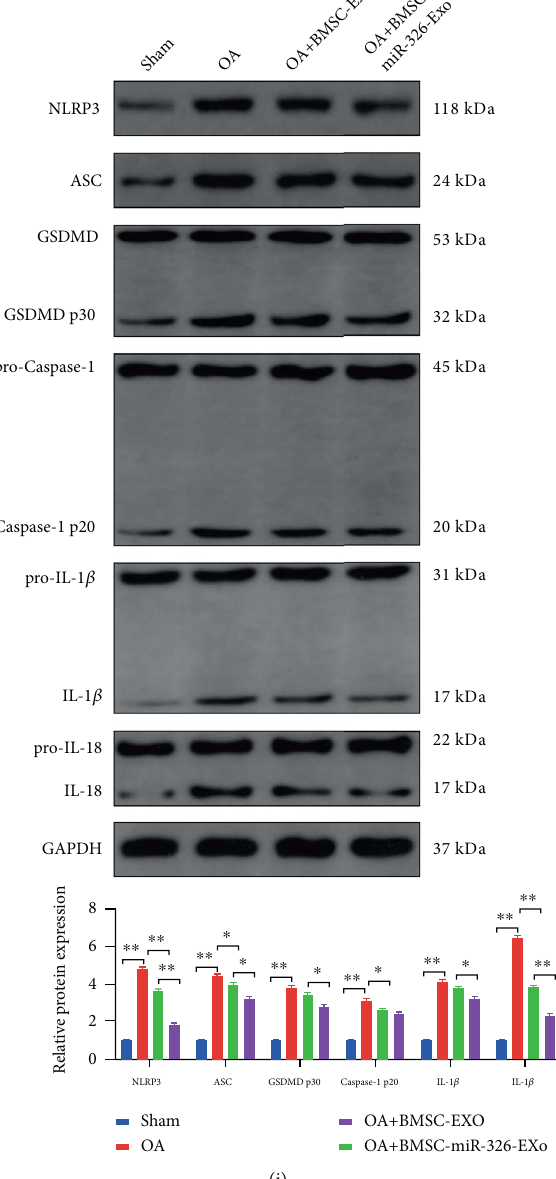
Figure 7: BMSCs exosomal deliver miR-326 to cartilage and inhibit cartilage pyroptosis via activating STAT1 by targeting HDAC3. (a) BMSC-Exos incubation reversed the reduction of ICRS scores induced by OA; (b) HE staining results of cartilage tissue in each group, bar = 20 μ m ; (c): Safranin-O/Fast Green staining results of cartilage tissue in each group, bar = 20 μ m ; (d) expression levels of miR-326, HDAC3, and chondrogenic-speci fi c genes (COL2A1, SOX9, Agg, and Prg4); mRNAs in OA chondrocytes of each group and BMSC- Exos incubation reversed the down-regulated mRNA level of chondrogenic-speci fi c genes in cartilage induced by OA; BMSC-Exos with overexpression of miR-326 had a more signi fi cant e ff ect; (e) BMSC-Exos incubation counteracted the increase levels of proin fl ammatory factors (IL-1 β , IL-18, IL-6, and TNF- α ) in cartilage induced by OA, and BMSC-Exos with overexpression of miR-326 had a more signi fi cant e ff ect; (f) BMSC-Exos incubation counteracted the increase of DNA-binding activity of NF- κ B p65 in cartilage induced by OA, and BMSC-Exos with overexpression of miR-326 had a more signi fi cant e ff ect; (g) BMSC-Exos incubation counteracted the increase of Caspase-1 activity in cartilage induced by OA, and BMSC-Exos with overexpression of miR-326 had a more signi fi cant e ff ect;